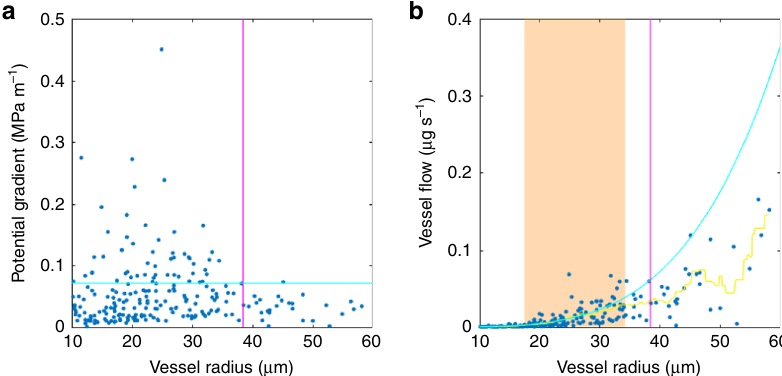
Fig. 7 The relationship between vessel radius, pressure gradient and fl ow rate. For all vessels in the inner region, with radius over 10 µ m ( n = 306), the gradient ( a ) and fl ow rate ( b ) are shown as a function of lumen radius. In a, the magenta line shows fl ow-weighted mean vessel radius and the cyan line shows fl ow-weighted mean gradient. In b, the magenta line shows fl ow-weighted mean vessel radius, the cyan curve shows idealized (Hagen – Poiseuille) fl ow rate over the range of radii 10 – 60 µ m for the fl ow-weighted mean gradient, orange zone shows the range of radii over which the idealized relationship fi ts the fl ow-radius points (t-test of residuals from points in 6- µ m window cannot reject 0 mean at α = 0.05; p -values, t-statistics, and degree of freedom counts of separate tests in Supplementary Table 1), and yellow curve shows the running mean fl ow rate over a 6- µ m window.